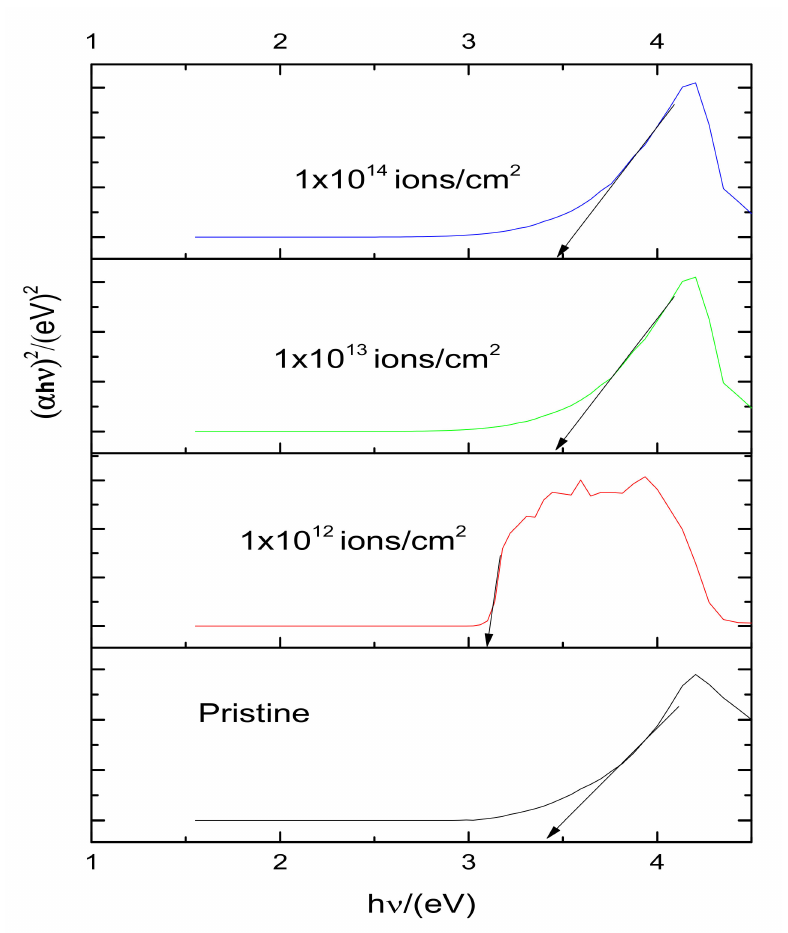
Figure 9. Tauc’s plot for pristine and Cu implanted